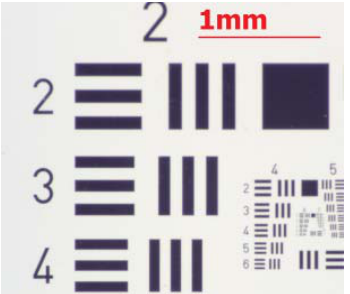
Fig. 3. Calibration